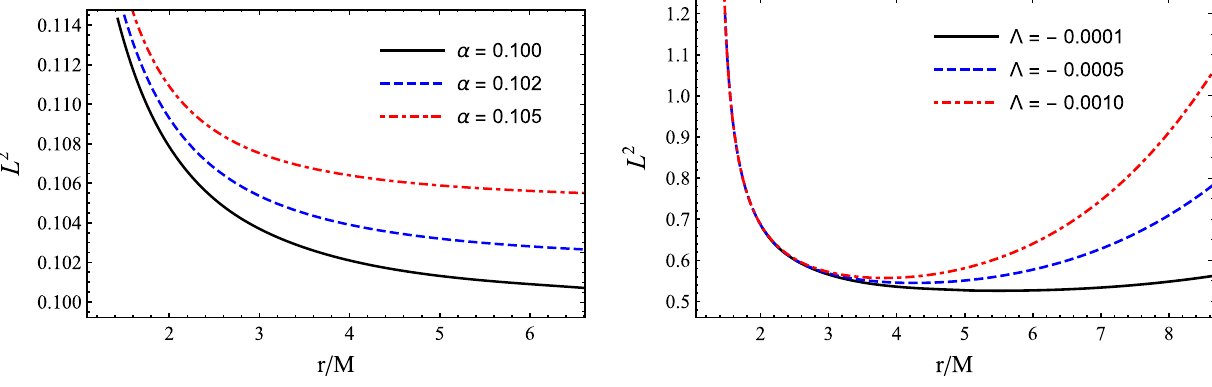
cosmological constant, i.e. (cid:4) = 0. Right panel: for different values of the cosmological constant in the case of fixed α = 0 . 5